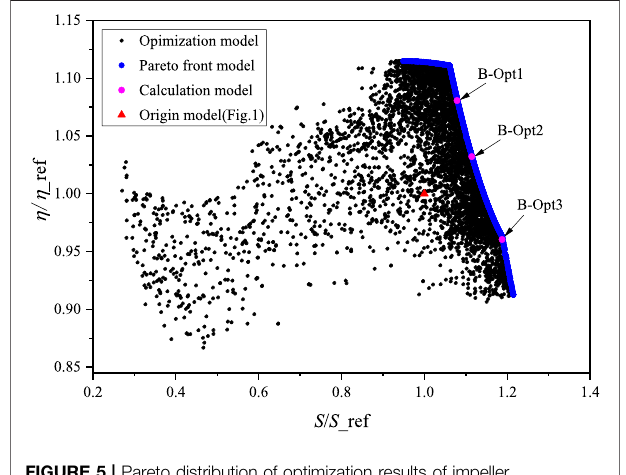
FIGURE 5 | Pareto distribution of optimization results of impeller geometry.